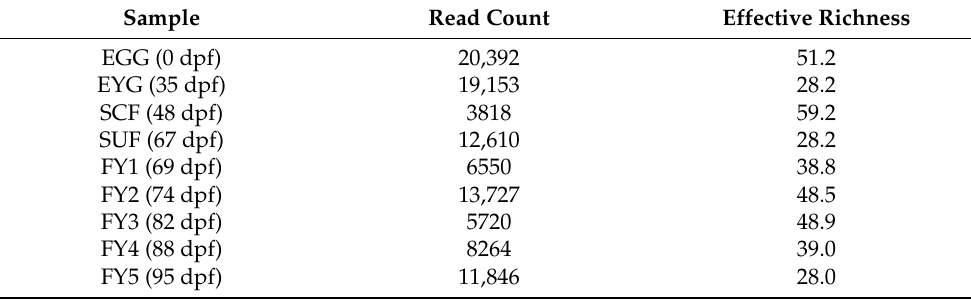
Table 1. Read count and α -diversity (effective richness) as average